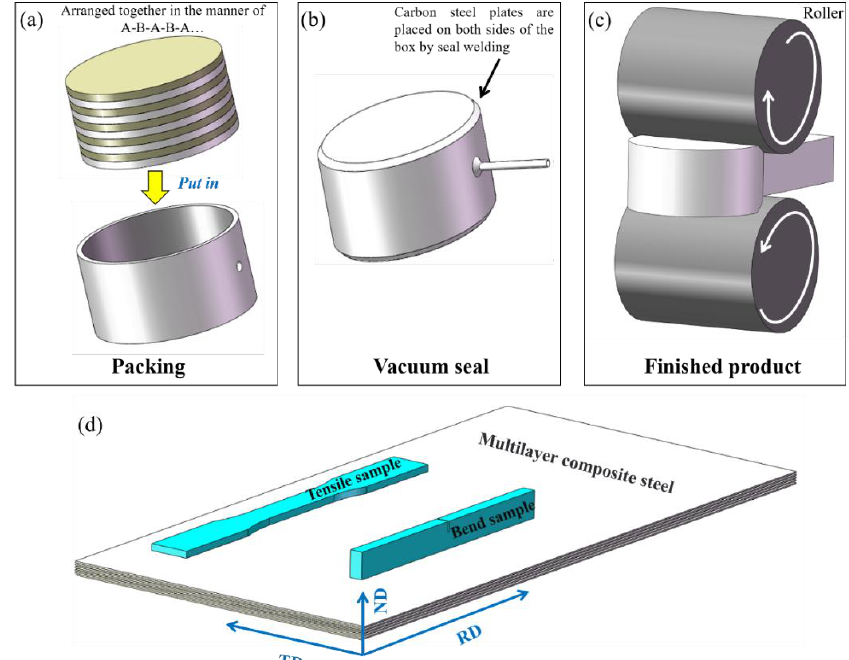
Figure 1. Schematic diagram of ( a – c ) fabrication process and ( d ) the tensile and bending samples of multilayer steels. Table 1. The chemical composition of raw 18Mn and 40Si2CrMo [wt.%].